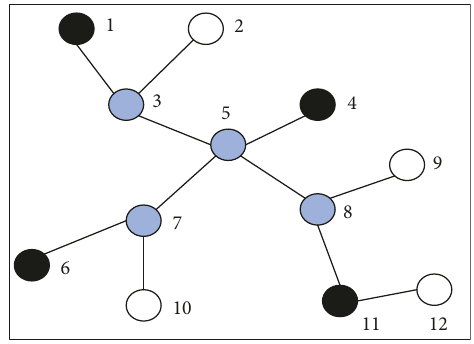
Figure 8: The reconstructed